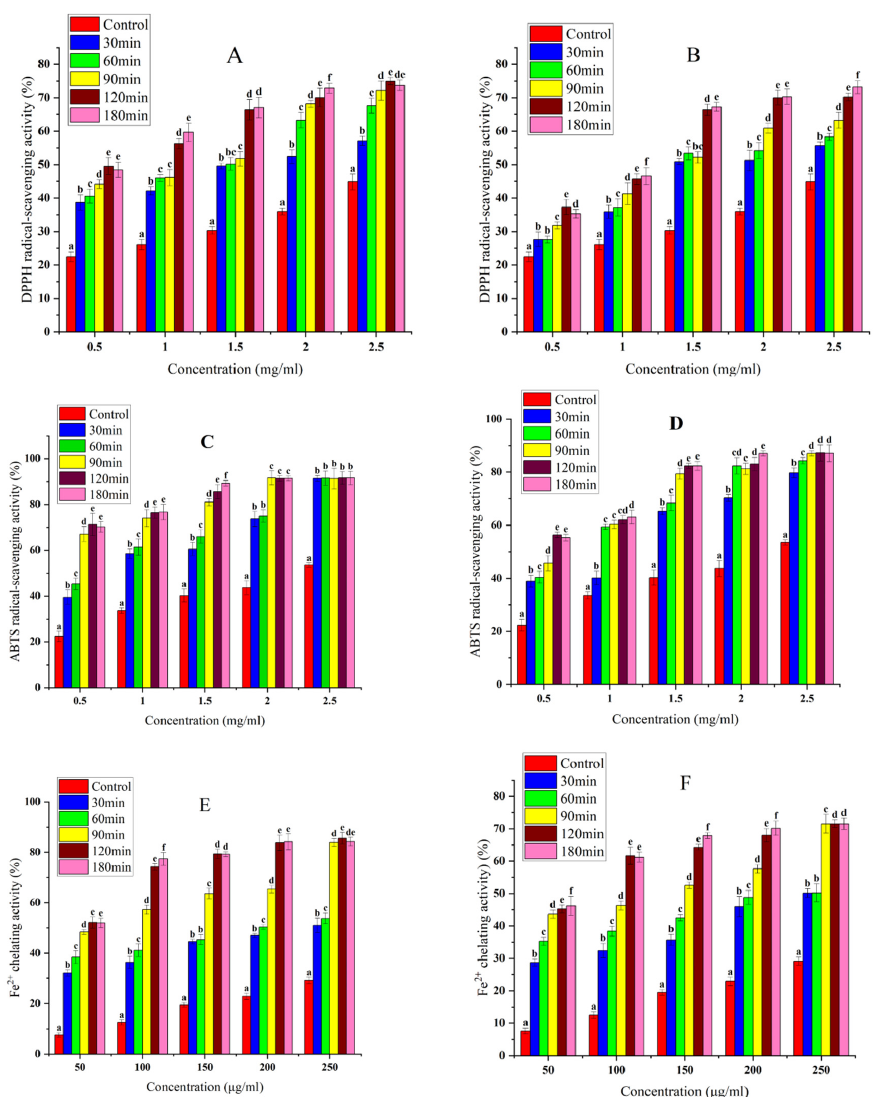
Figure 8. Radical-scavenging activity of SPI and its hydrolysates at different concentrations. DPPH radical-scavenging activity: ( A ) ACHNs; ( B ) DCHNs, ABTS radical-scavenging activity; ( C ) ACHNs; ( D ) DCHNs, metal ion chelating activity: ( E ) ACHNs; ( F ) DCHNs. Different letters (a–f) indicate significant differences among hydrolysates at time function for the same concentration( p < 0.05).